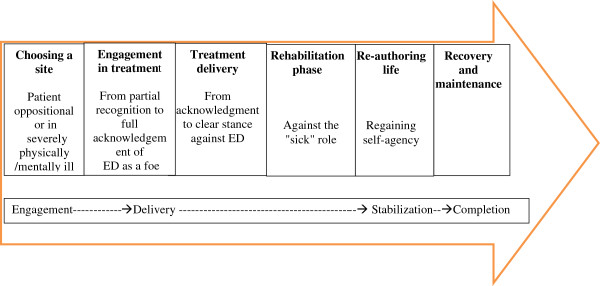
The client journey.